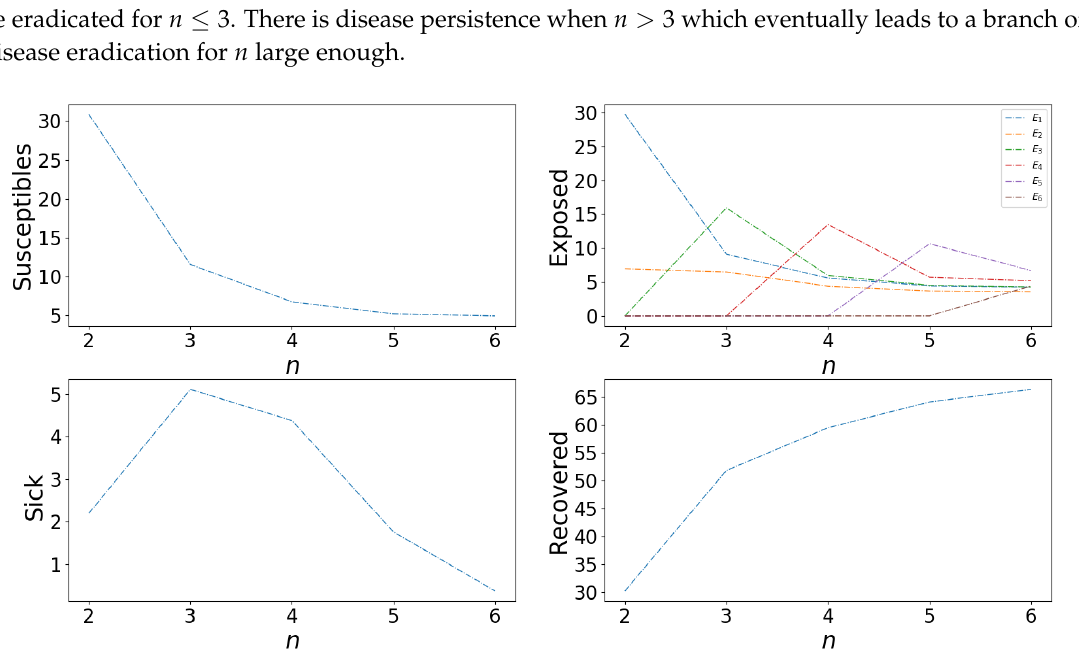
Figure A1. Behaviors of infectious classes relative to n . The horizontal axes represent the number of asymptomatic stages and the vertical axes represent the percentage of human populations. The disease can be eradicated for n ≤ 3. There is disease persistence when n > 3 which eventually leads to a branch of disease eradication for n large